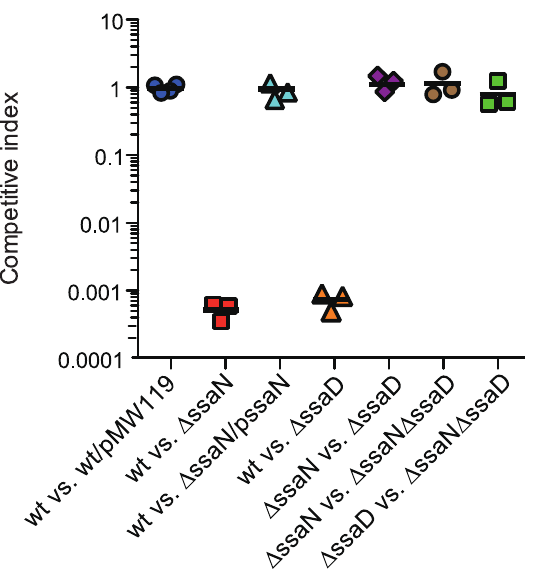
Figure 6. SsaN causes the release of the SsaE-bound effector/ translocator protein SseB. Purified SsaN-Myc-His 6 or SsaN R192G -Myc- His 6 was incubated with GST-SsaE and SseB-FLAG protein complexes in the presence of ATP or the non-hydrolyzable ATP derivative ATP- c S, as indicated. Total cell lysates of E. coli that expressed SseB-FLAG, bound proteins, and proteins in the supernatant were analyzed by immuno- blotting using anti-FLAG and anti-GST antibodies.